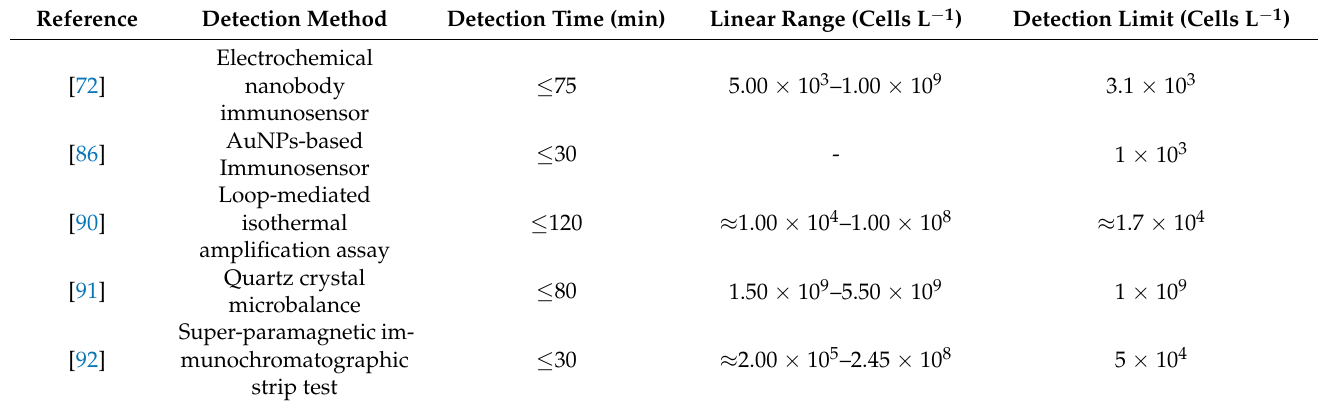
Table 3. Comparison of several A. minutum detection methods by biosensors/assays.